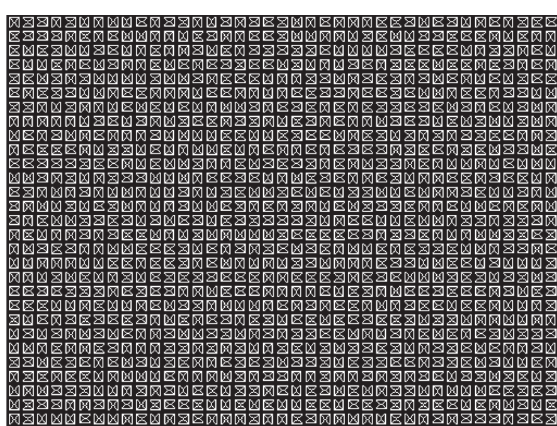
Figure 3: 39 × 29 M-array with 2 × 2 window